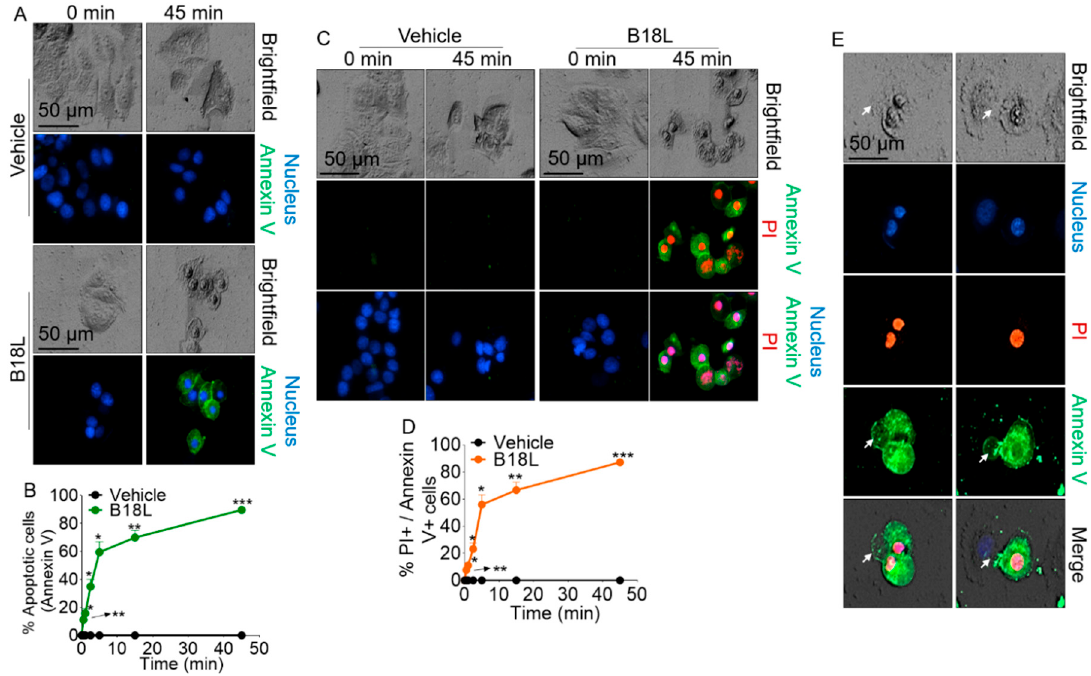
Figure 7. Effect of B18L on Annexin V binding to Phosphatidylserine (PS). ( A ) Pattern of 4 ′ ,6-diamidino-2-phenylindole (DAPI) and Annexin V staining of MCF7-G11-TR5 cells following vehicle (upper) or B18L (lower) treatment at 0 and 45 min. Fluorescence images were manually obtained at 10× using the Lionheart FX automated microscope. Scale bar: 50 µm. ( B ) Quantification of cells in panel A exhibiting externalized PS designated as Annexin V+ cells. Five 10× fields of view were analyzed at 0.5, 1, 2.5, 5, 15 and 45 min. Two-tailed Welch’s t test was used to compare the differences between vehicle and B18L at each concentration. *** p < 0.005, ** p < 0.01, * p < 0.05 and nonsignificant was not shown for clarity. ( C ) Pattern of DAPI, PI and Annexin V staining of MCF7-G11-TR5 cells following vehicle (left) or B18L (right) treatment at 0 and 45 min. Fluorescence images were manually obtained at 10× using the Lionheart FX automated microscope. Scale bar: 50 µm. ( D ) Quantification of cells in panel C exhibiting internalized PI (PI + ) and externalized PS (Annexin V + cells). Five 10 × fields of view were analyzed at 0.5, 1, 2.5, 5, 15 and 45 min. Two-tailed Welch’s t test was used to compare the di ff erences between vehicle and B18L at each concentration. *** p < 0.005, ** p < 0.01, * p < 0.05 and nonsignificant was not shown for clarity. ( E ) Representative images of Annexin V + membrane blebs. White arrows indicate Annexin V + membrane blebs. Experiment was repeated at least three times, with similar